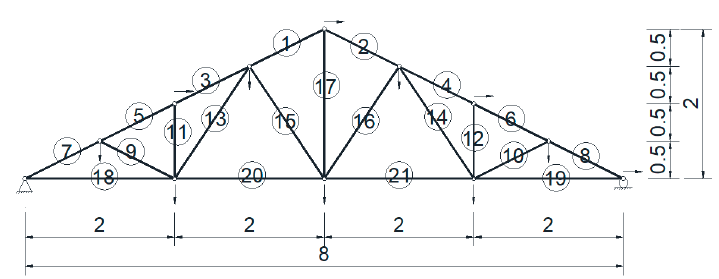
Figure 7. Schematic of a 21-bar planar truss (unit: m).